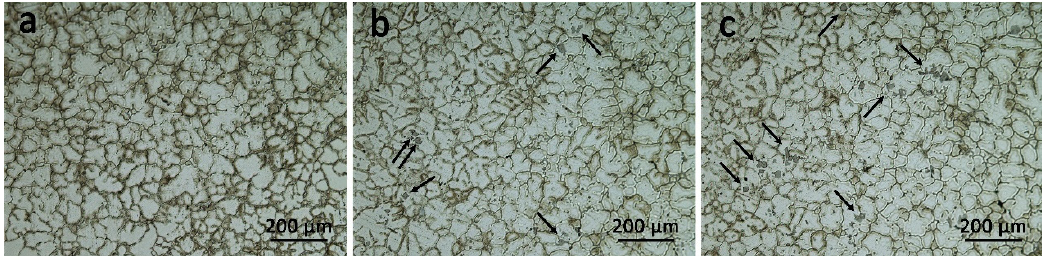
Figure 3. Metallographic images of three as-cast alloys ( a ) Er-free; ( b ) 0.09Er, ( c ) 0.20Er.